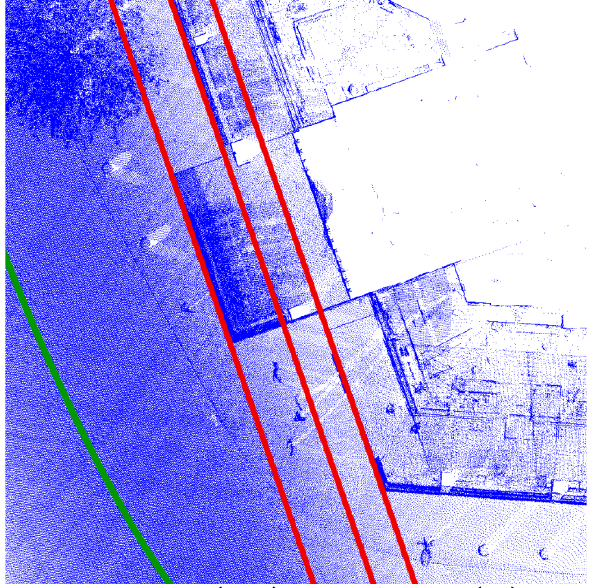
Figure 6. Track (green) and identified layers (red)